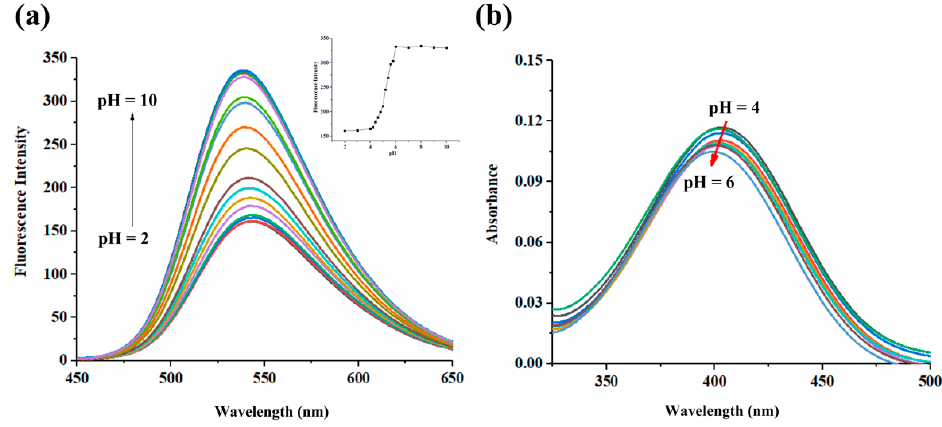
Figure 1. Effect of pH on ( a ) fluorescence and ( b ) UV–Vis absorption spectra of MMN at concentra- tions of 1.00 × 10 − 5 M. Inset: The maximum fluorescence intensity of MMN in different pH solutions at 529 nm.